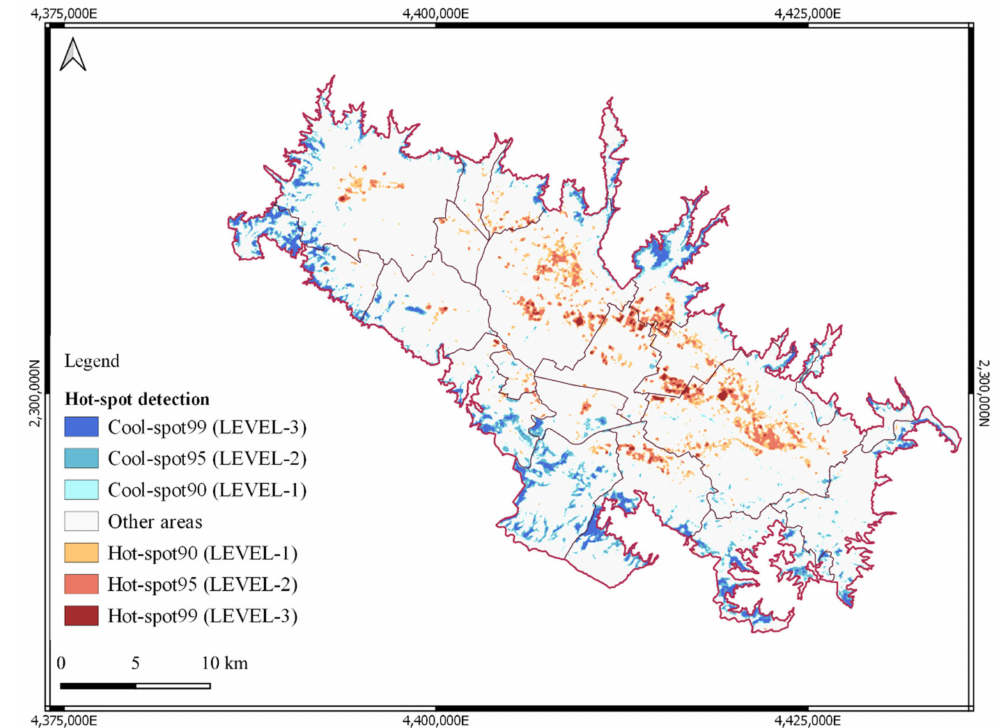
Figure 5. Hot-spot detected